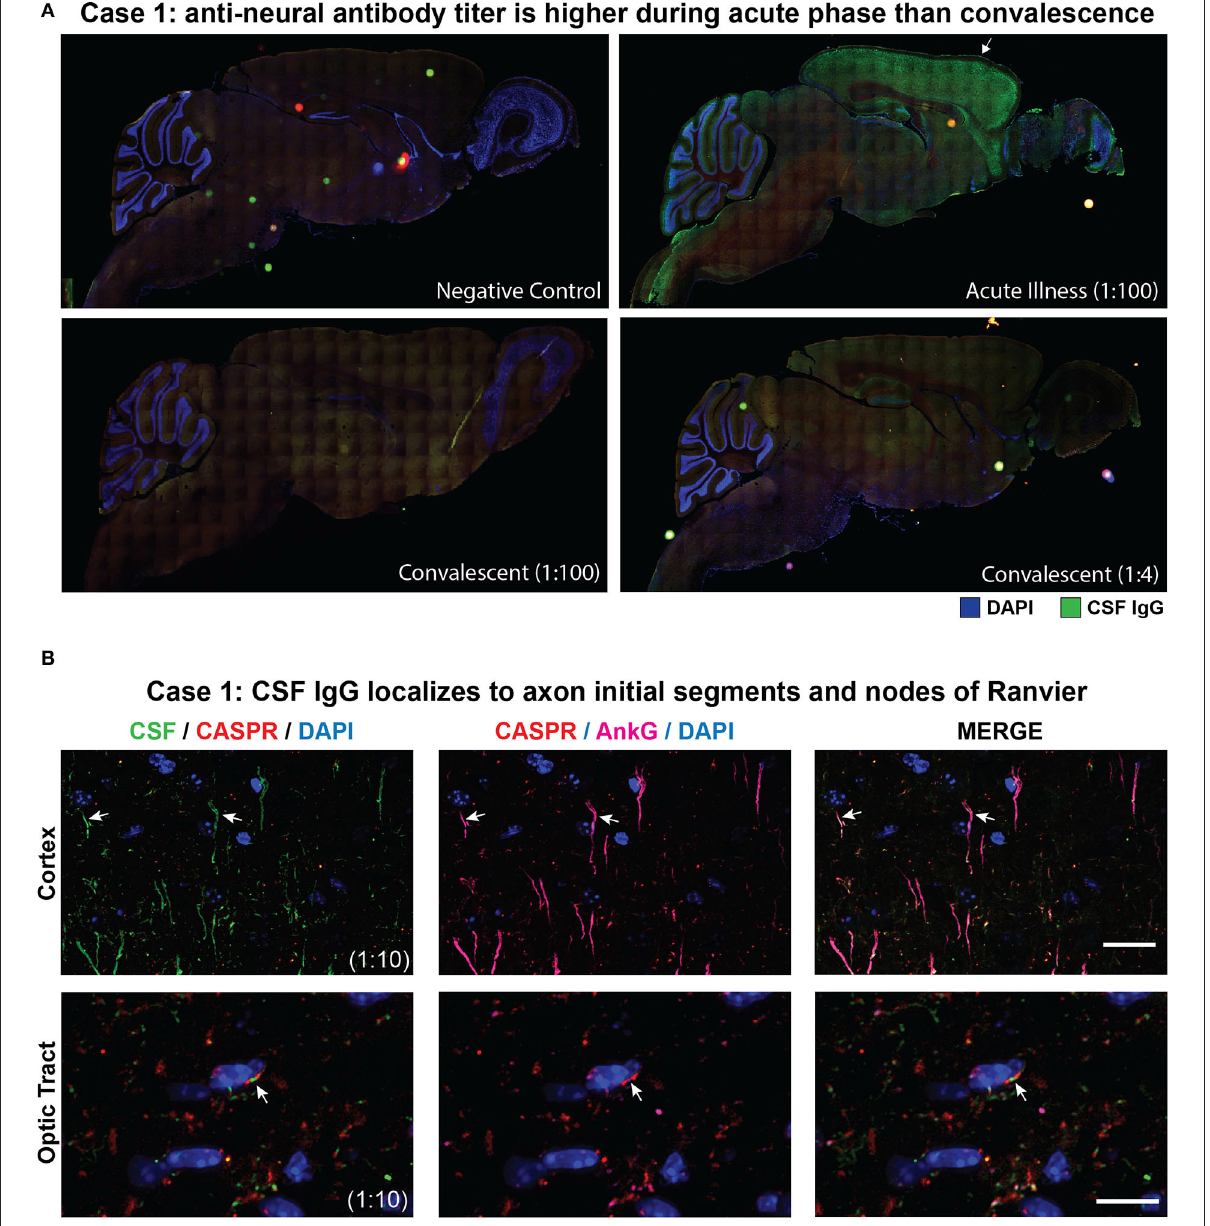
FIGURE2 Tissue-based immunofluorescence (TBIF) assays. (A) Panoramic images of sagittal mouse brain TBIF with acute-phase CSF at a 1:100 dilution or convalescent CSF at a 1:4 dilution. (B) Colocalization of case 1 acute-phase CSF with AnkG at the AIS in the cortex (arrows, top row) and NoR in the optic tract (arrows, bottom row). Nodal CSF IgG localizes to the NoR delimited by paranodal CASPR (red). Scale bars = 10 µ